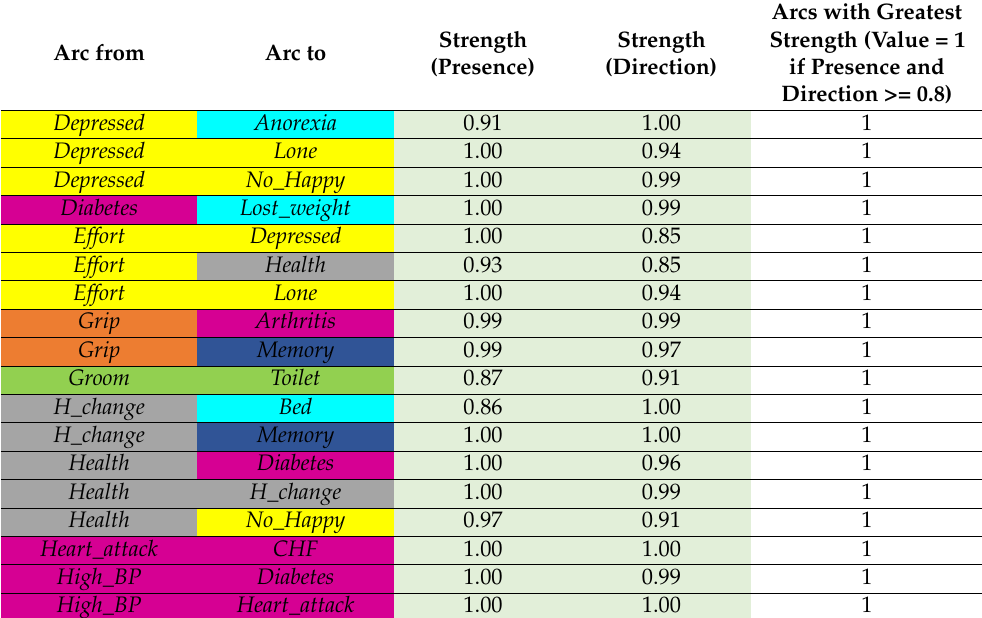
Table A2. Arcs and strength, for both the presence and direction, corresponding to the averaged Bayesian network concerning frailty components and